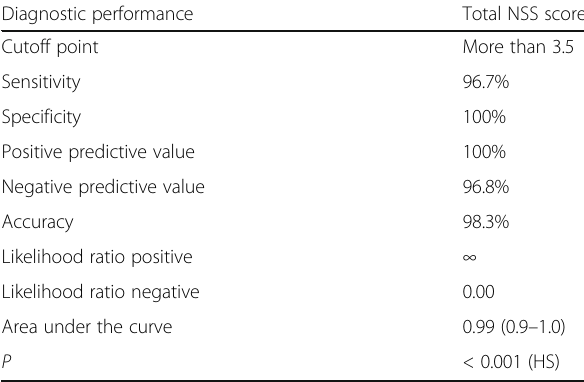
Table 5 Diagnostic performance accuracy of total NSS score in discrimination between patients group and control